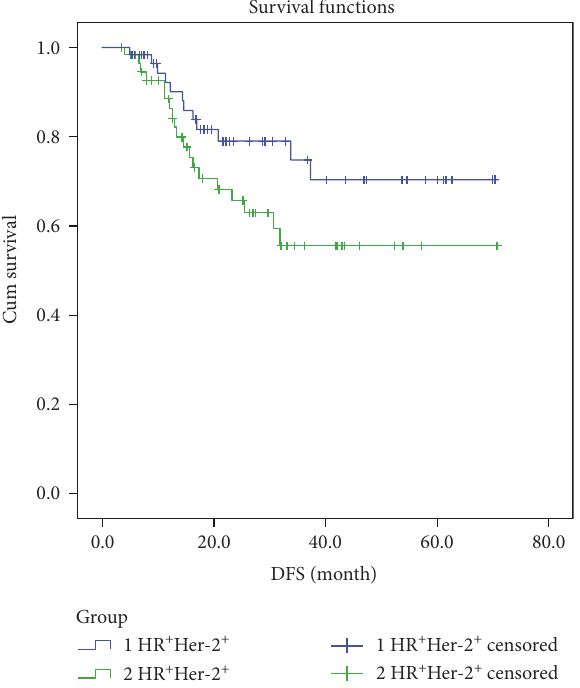
Figure 1: Kaplan-Meier 3-year DFS estimation in pCR and non-pCR patients.